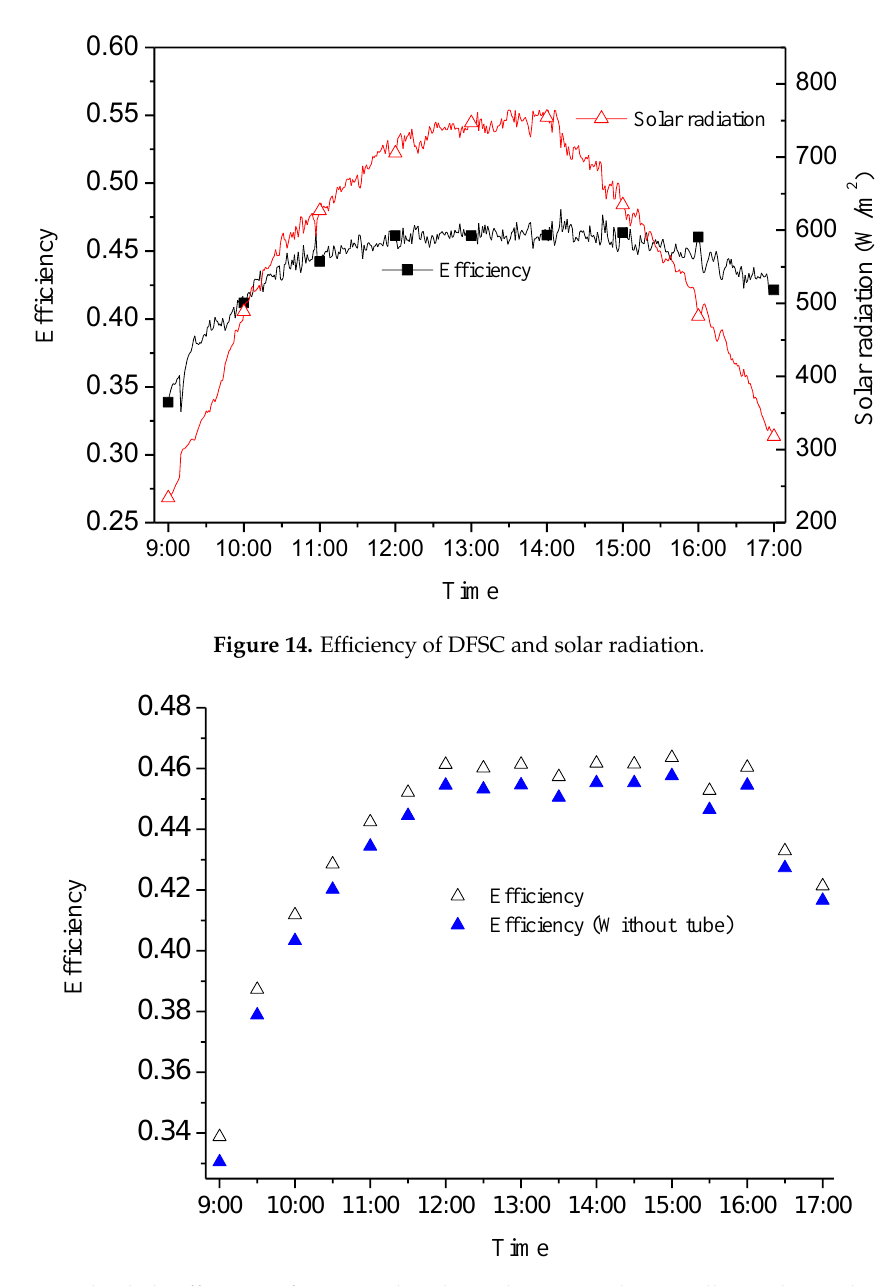
Figure 15. The daily efficiency of DFSC and traditional passive solar air collector that with no tube.